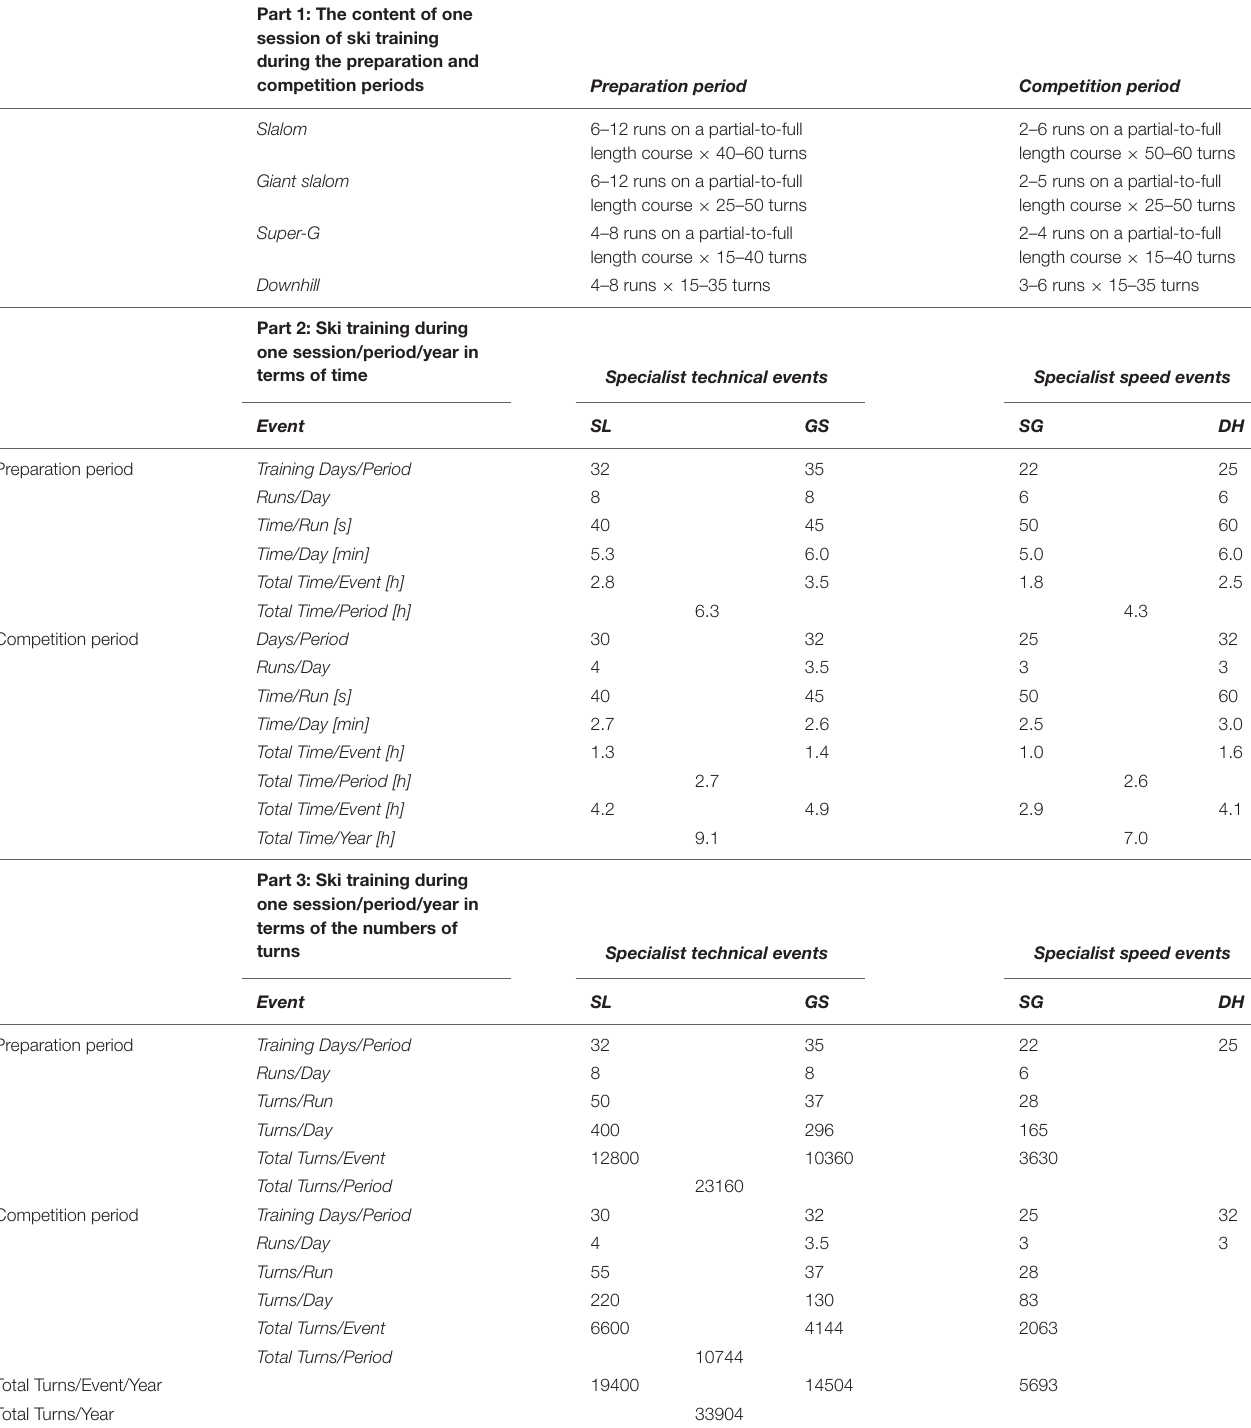
TABLE 1 | Typical volumes of ski training by Olympic alpine skiers.